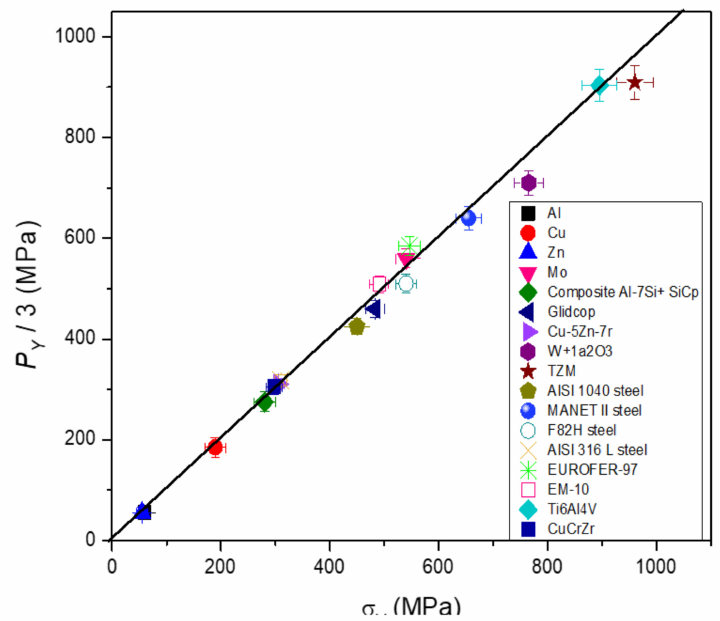
Figure 3. P Y /3 from FIMEC test are plotted vs. σ Y data from tensile tests of different metals and alloys. All the points are close to the bisector line showing that σ Y is approximatively equal to P Y